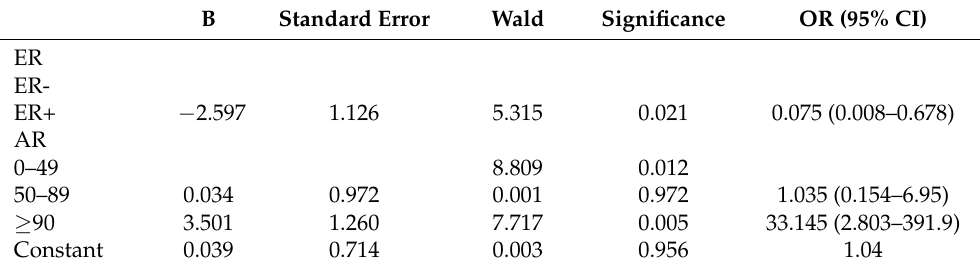
Table 3. Factors influencing neoadjuvant therapy response after selection. ER estrogen receptor, AR androgen receptor, OR odds ratio, CI confidence interval.